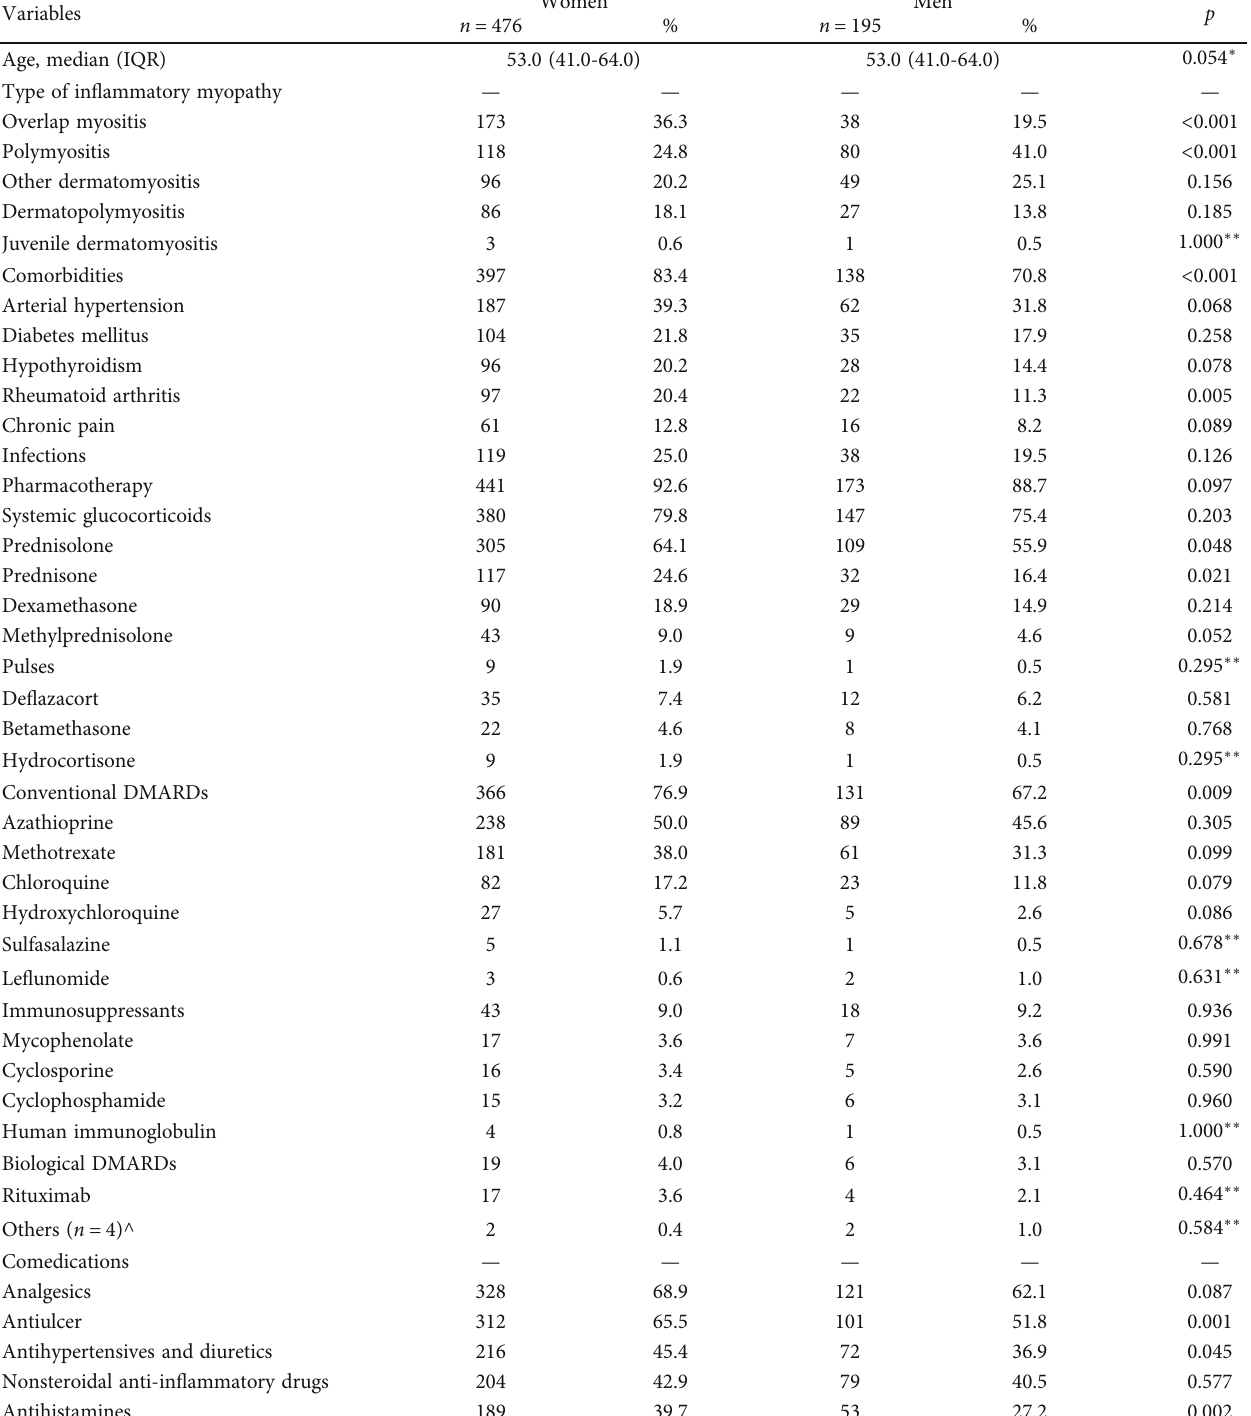
Table 2: Comparison of some sociodemographic and pharmacological variables between women and men diagnosed with autoimmune idiopathic in fl ammatory myopathies in